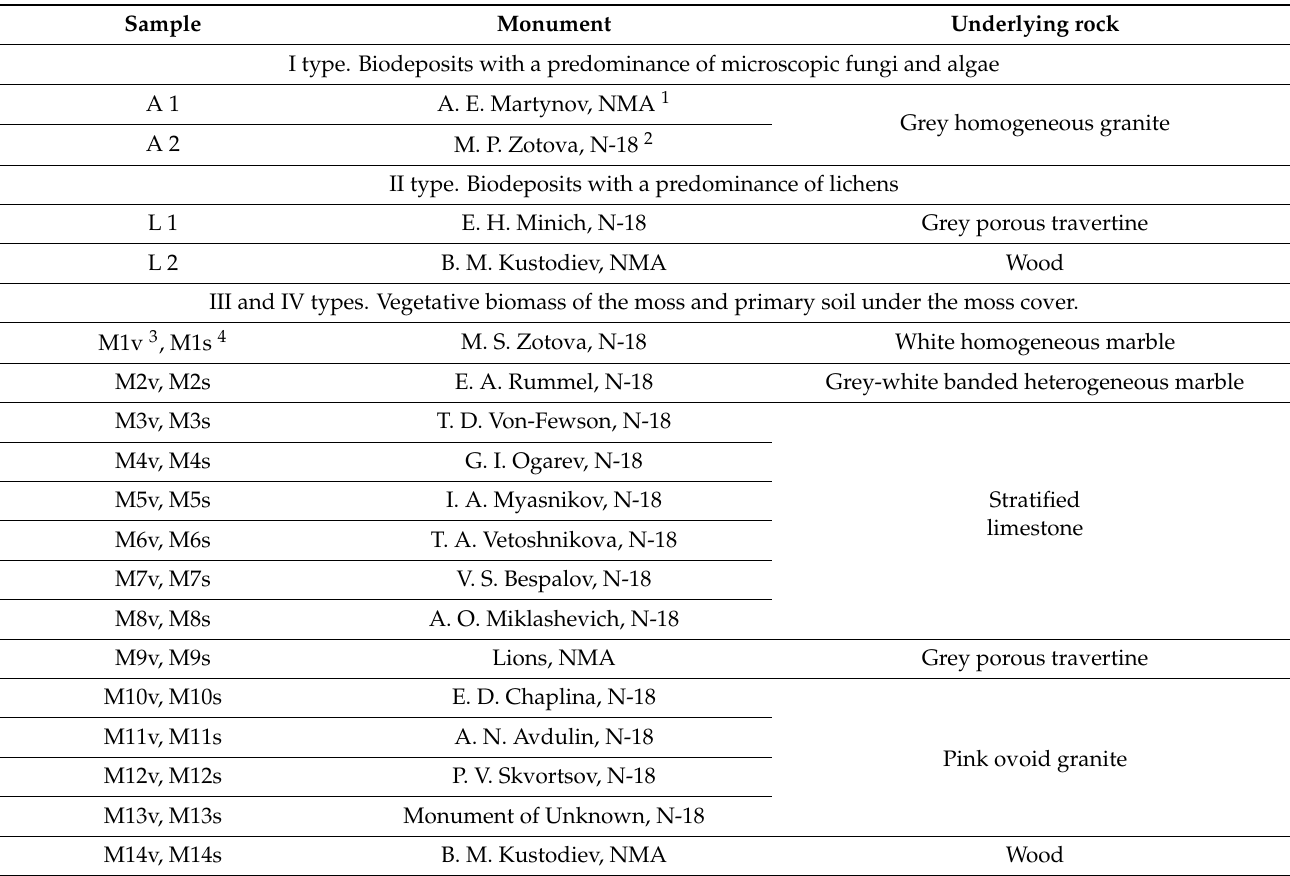
Table 1. List of the biodeposits samples collected from Saint Petersburg necropoleis monuments.